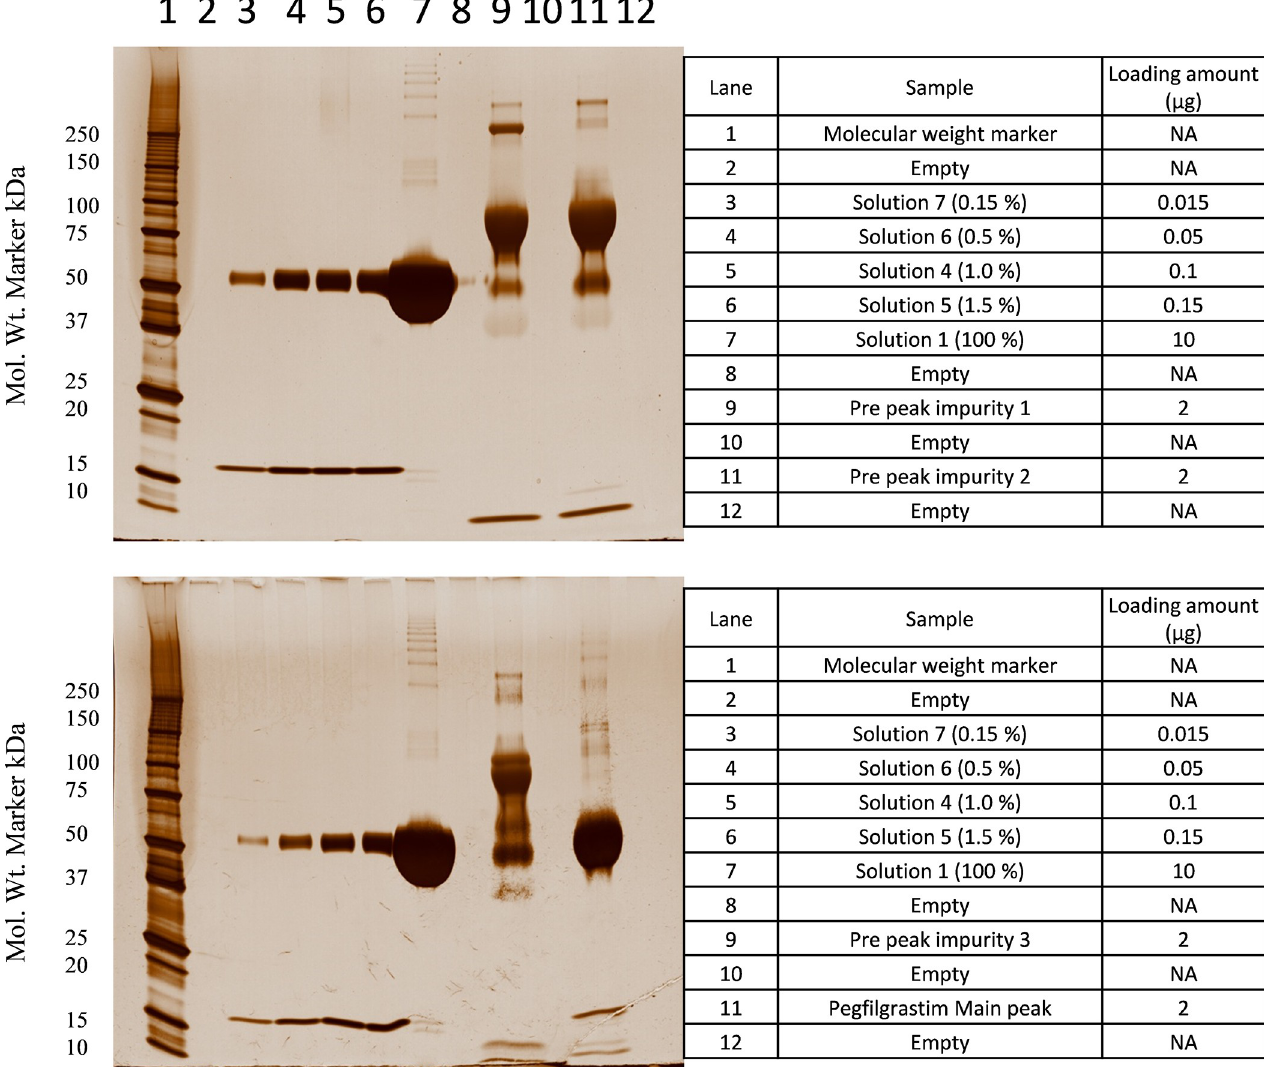
Fig 9. SDS-PAGE analysis of Sample I4-CEx impurity peaks (pegylation mixture output). (Solution 1, Solution 4, Solution 5, Solution 6 and Solution 7 are the internal Reference Standard solutions).